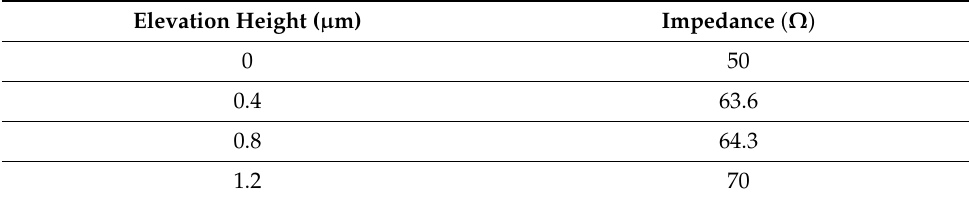
Figure 9. ( a ) Impedance variation caused by CPW structure elevation. ( b ) impedance tuning is realized by adjusting the DC bias pad size. Table 2. CPW impedance & its elevation height above the silicon